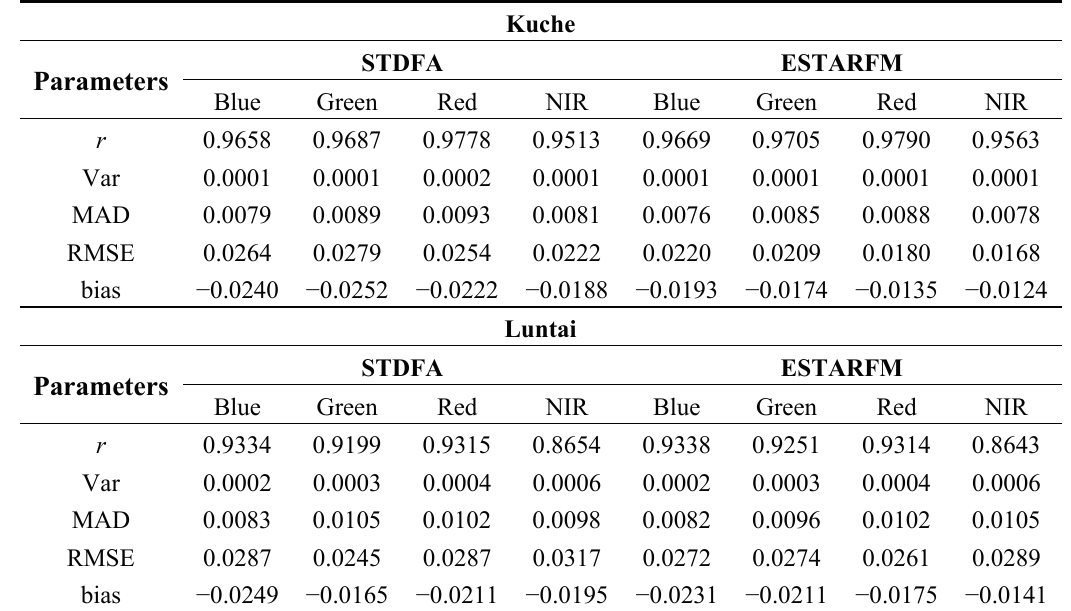
Figure 3. Comparison of MODIS, GF-1 WFV and synthetic data generated by ESTARFM and STDFA acquired on 7 October 2013: ( a ) MODIS data; ( b ) synthetic GF-1 WFV data generated by STDFA; ( c ) synthetic GF-1 WFV data generated by ESTARFM; ( d ) actual GF-1 WFV data. Table 5. Results of the correlation analysis between synthetic and actual GF-1 WFV